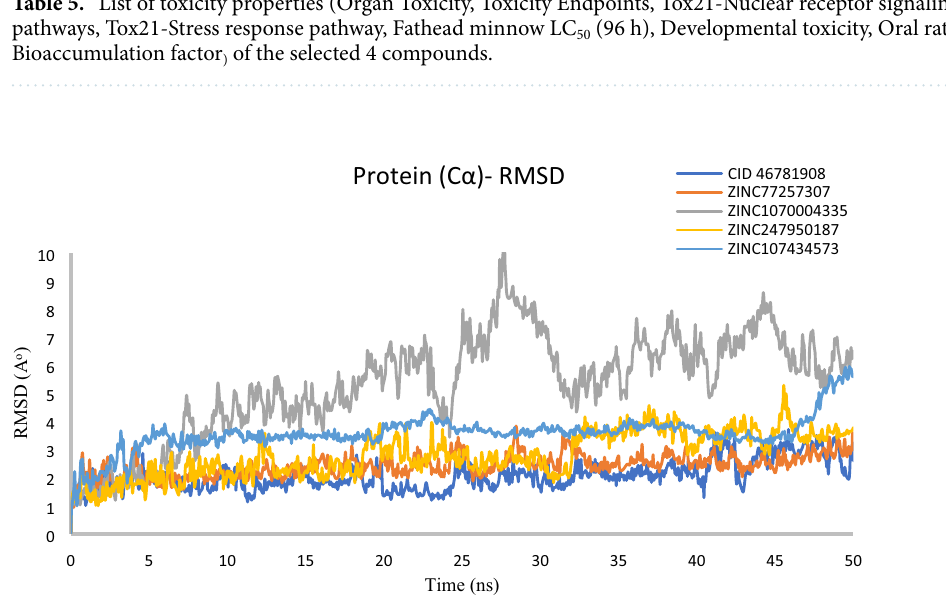
Figure 8. RMSD values extracted from Cα of the protein–ligand docked complexes, viz CID: 46781908 (Gray), ZINC77257307(orange), ZINC1070004335, ZINC247950187 (Gold), ZINC107434573 (Blue), with respect to 50 ns simulation